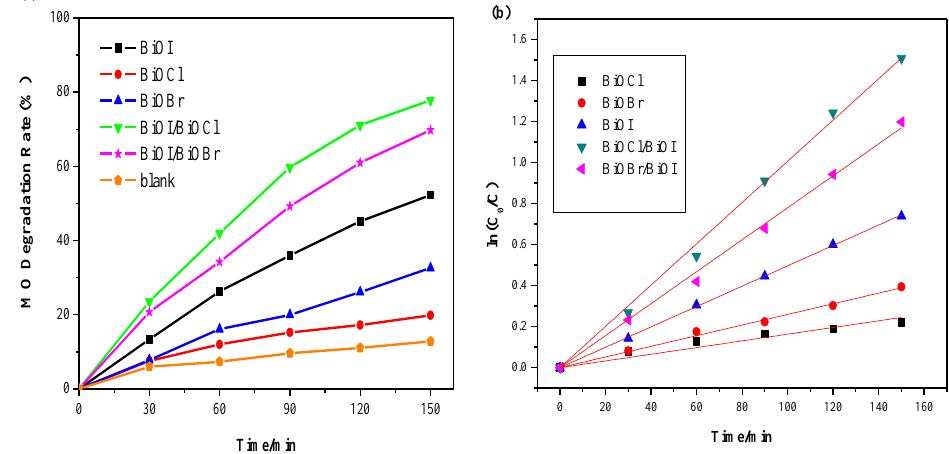
Figure 8. ( a ) Comparison of photodegradation efficiencies of different samples under visible irradiation; ( b ) pseudo-first-order kinetics curves of methyl orange (MO) degradation over different samples under visible irradiation.